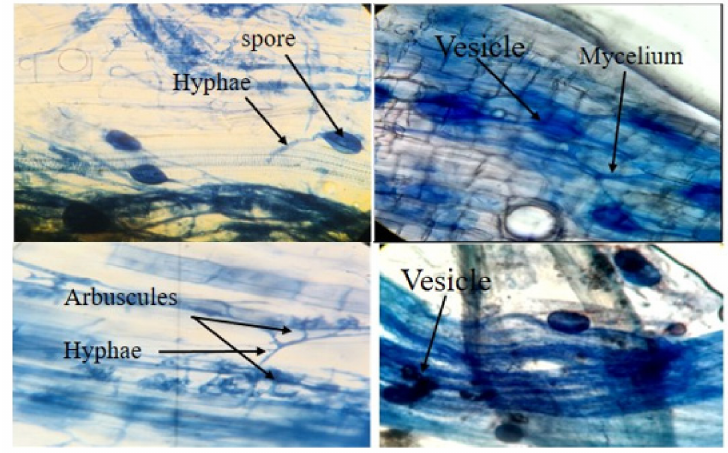
Figure 1. Microscopic images of the stained fragments of lettuce roots to detect the colonization of arbuscular mycorrhiza ( Glomus mosseae